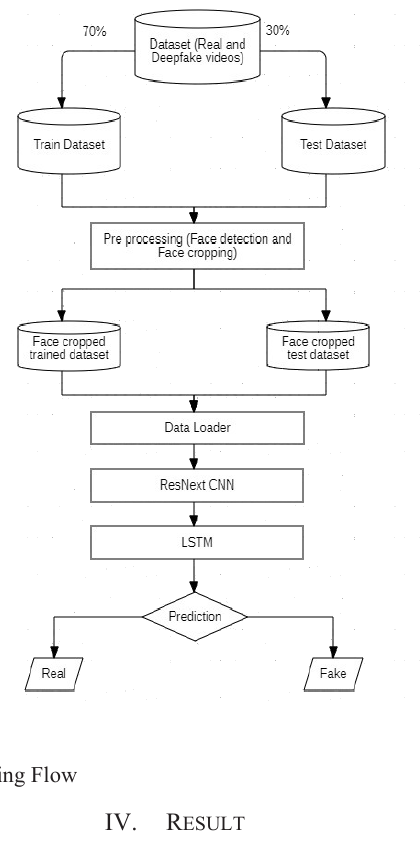
Fig. 6. Training Flow